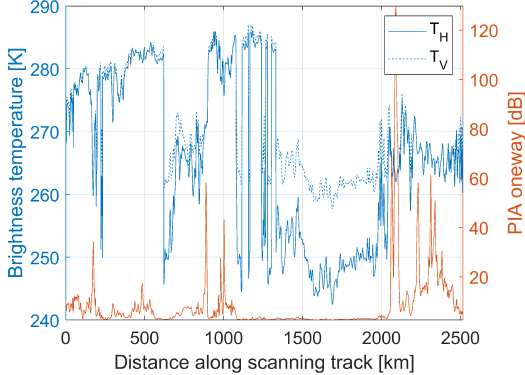
Figure 16. Simulated brightness temperatures for V (continuous blue) and H (dashed blue) polarization. For clarity of presentation, we have not added the expected measurement noise. The total one- way PIA (red line) is also given for reference. Results correspond to a full revolution of the WIVERN antenna, as shown in Fig.